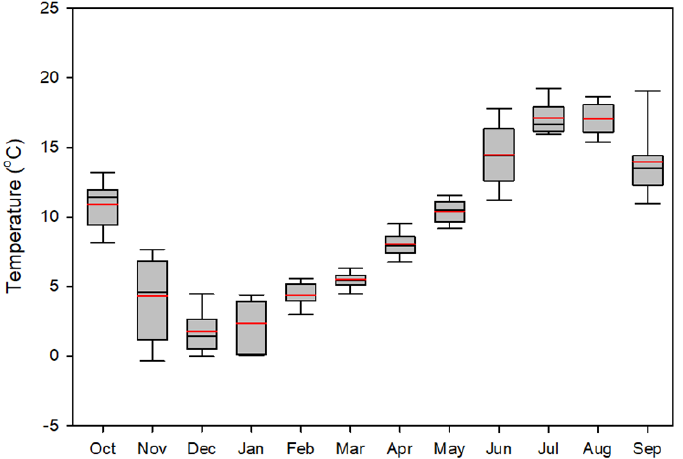
Figure 5. Box diagram showing the 17-sensor daily averaged stream temperature by month from October 2015 to September 2016. Each box shows the mean (red line) and median (black line). The upper and lower ends of the boxes represent the 25th and 75th percentiles. Lower and upper error bars represent the 10th and 90th percentiles.